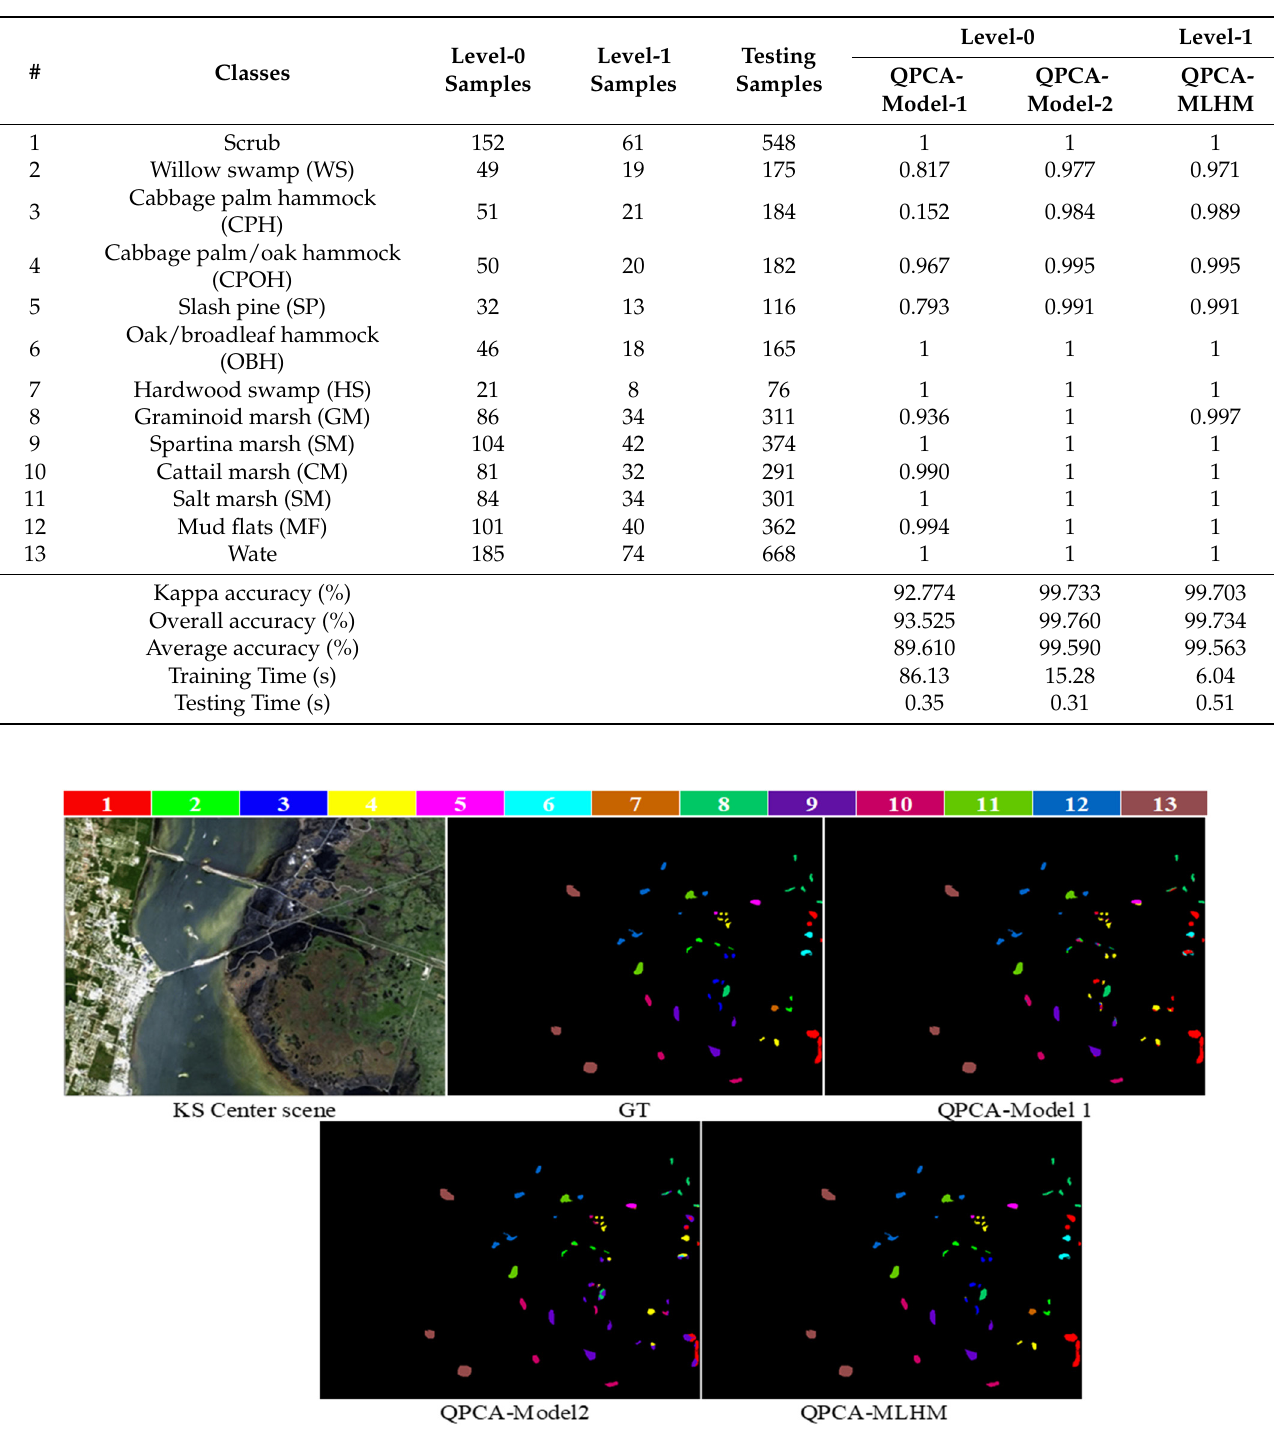
Table 5. The sample number of level-0 and level-1 datasets. It also indicates the two level-0 models’ results and the final results of the level-1 model for the KS_center dataset.